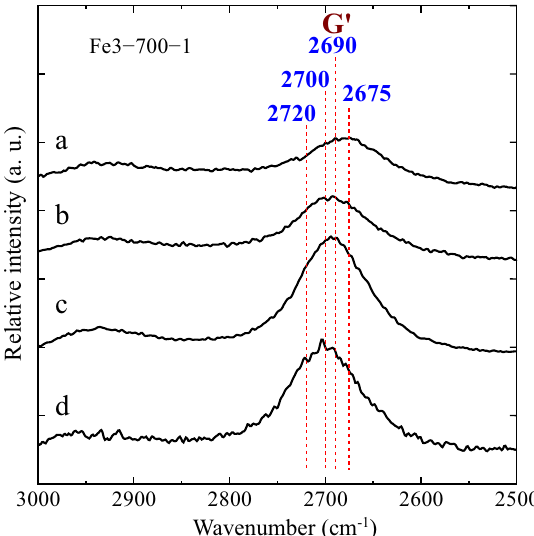
Fig. 3 Measurement-point dependence of Raman shifts and spectral line-shapes of G ʹ -bands observed from Fe3-700-1: a , b , c , d , Fe3-700-1